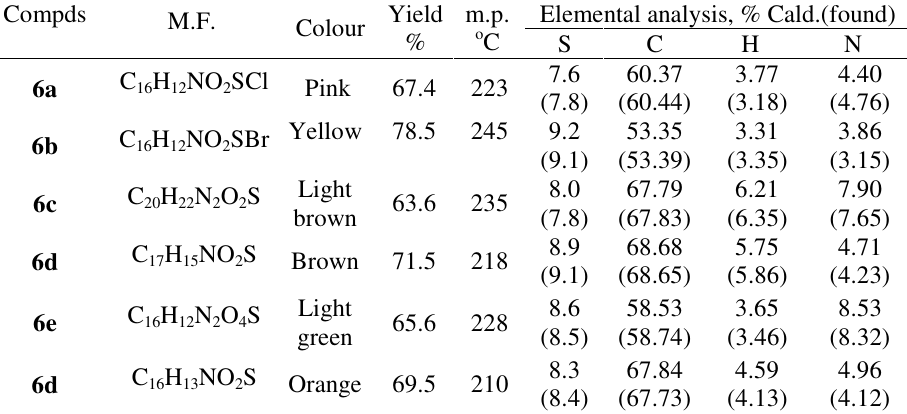
Table 2. IR, H 1 NMR Spectral data of the compounds ( 6a-f ).